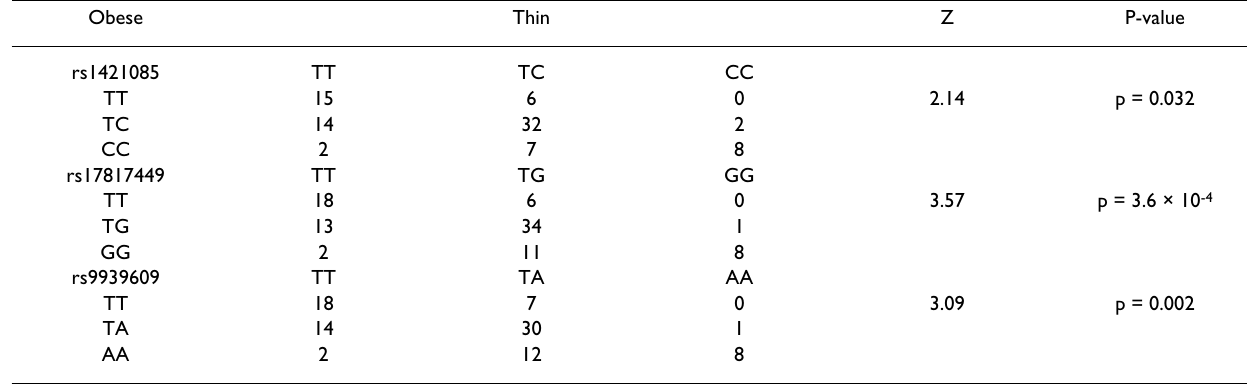
Table 4: Association analyses of extremely discordant sibling pairs. Obese